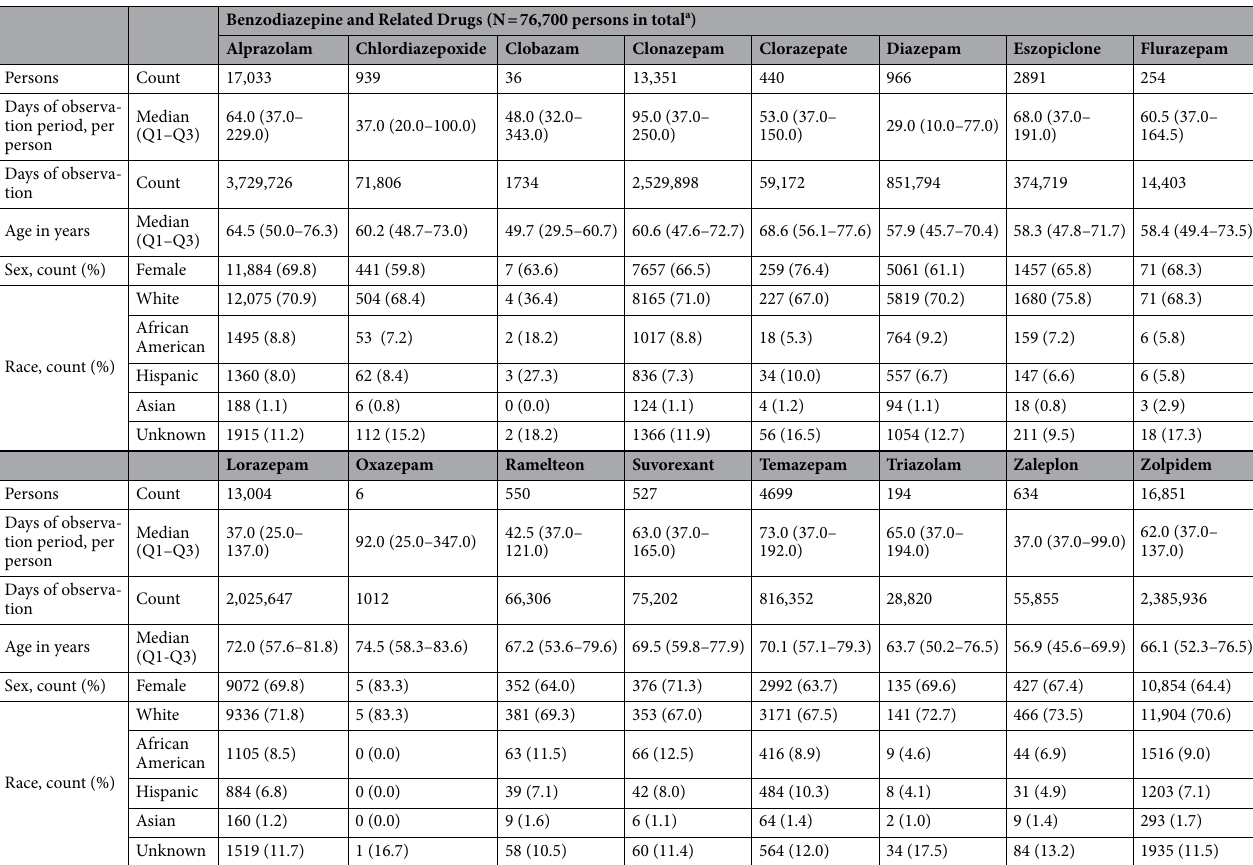
Table 1. Characteristics of benzodiazepine and related drug users experiencing an unintentional traumatic injury. Q, quartile. a A person may have contributed to multiple drug episodes in the analysis. Estazolam, quazepam, and tasimelteon were examined but did not have eligible samples with statistically stable models because none of the base pair-candidate interacting precipitant combinations had ≥ 5 exposed